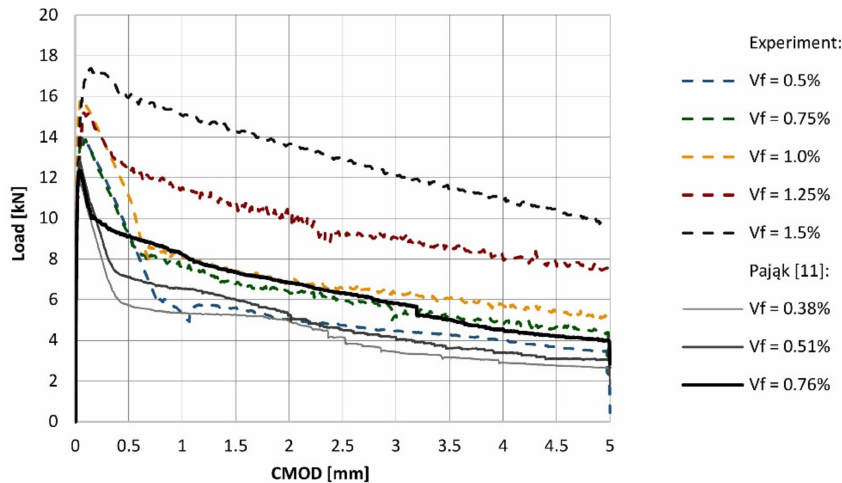
Figure 7. Average load-CMOD curves obtained in the flexural